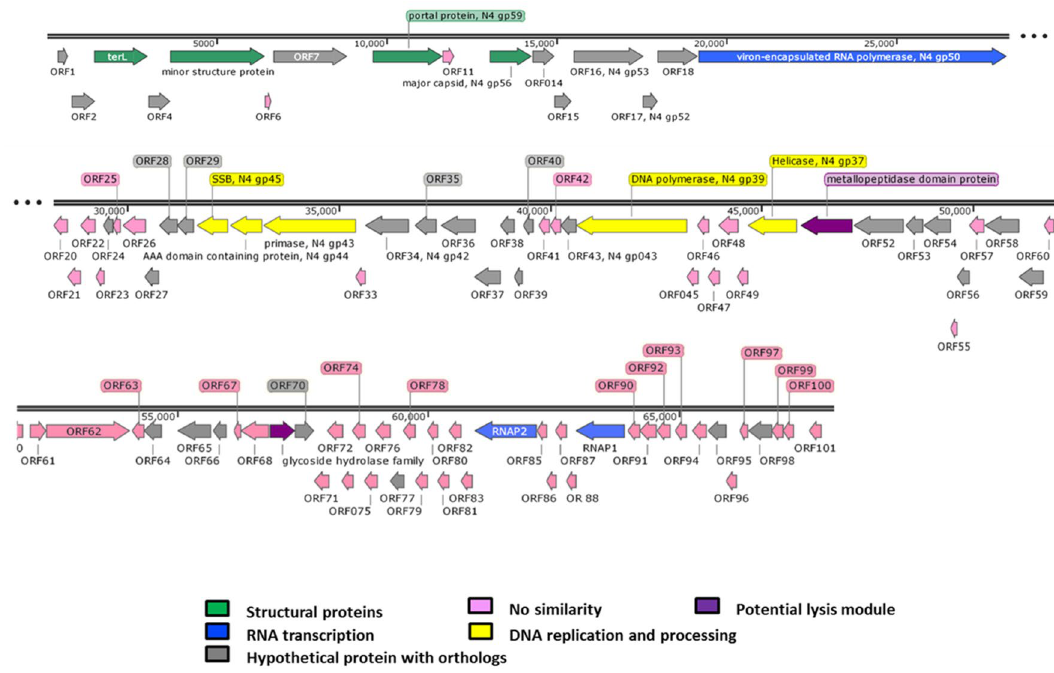
Figure 4. Genomic organization of phi50-12. Direction of the arrow represents transcription orientation. Colored box represents their functionality or